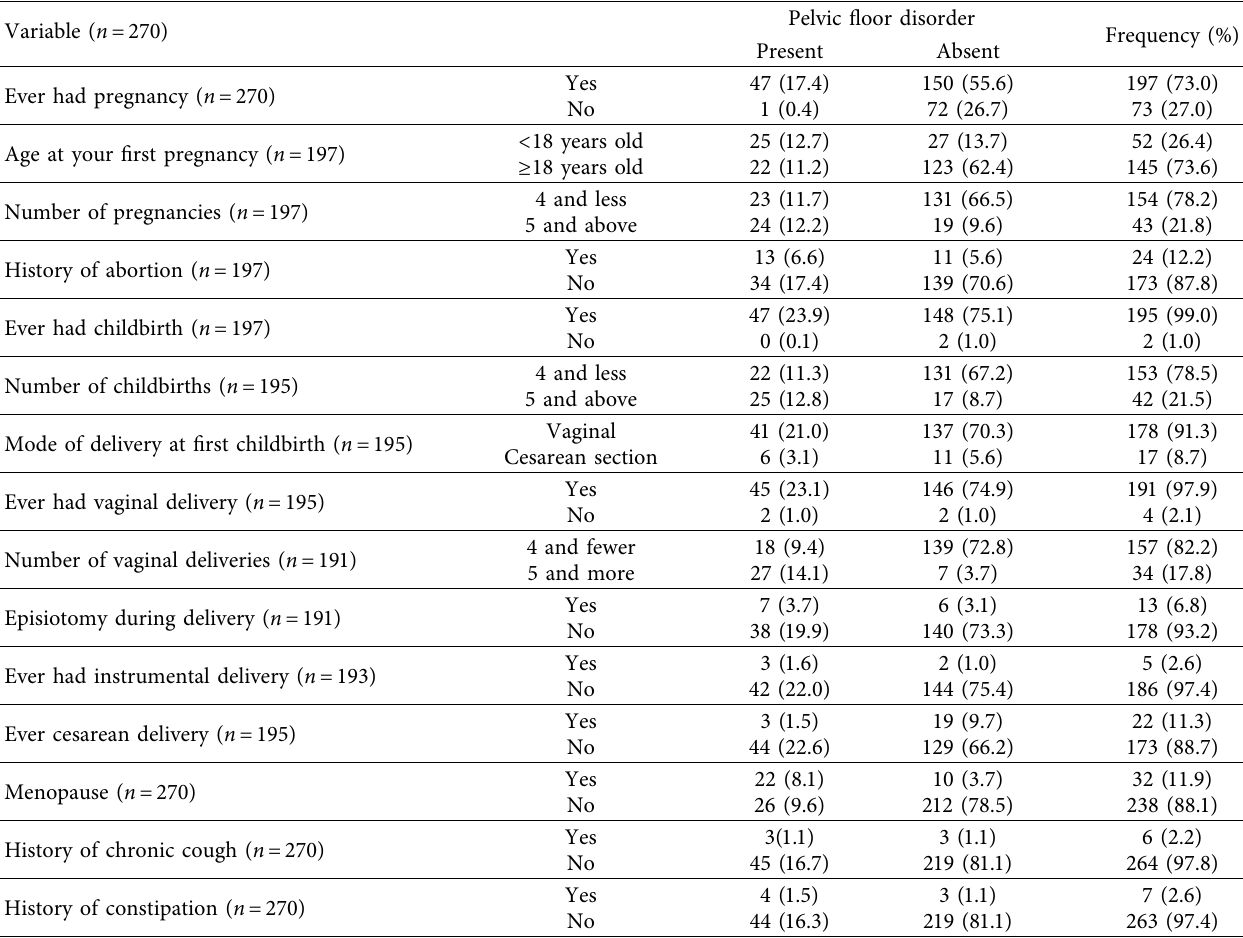
Table 2: Reproductive health and medical history of study